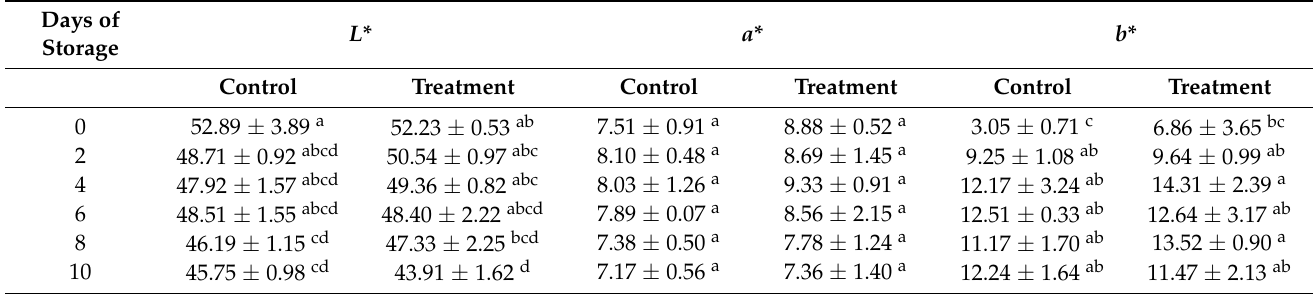
Table 1. Changes in color of deep-fat-fried chicken